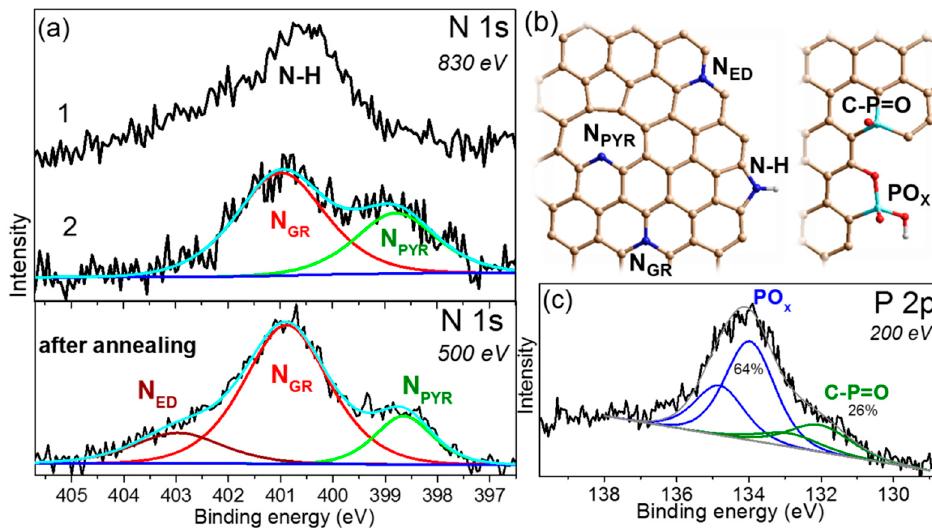
Figure 3. ( a ) N 1s XPS spectra of N-graphene film measured at an excitation energy of 830 eV before (1) and after (2) annealing in spectrometer chamber at 773 K and at 500 eV after annealing; ( b ) Models of N-graphene and P-graphene with heteroatoms (nitrogen shown by blue and phosphorus shown by light blue) identified by XPS; ( c ) P 2p XPS spectrum of P-graphene film measured at an excitation energy of 200 eV after annealing.